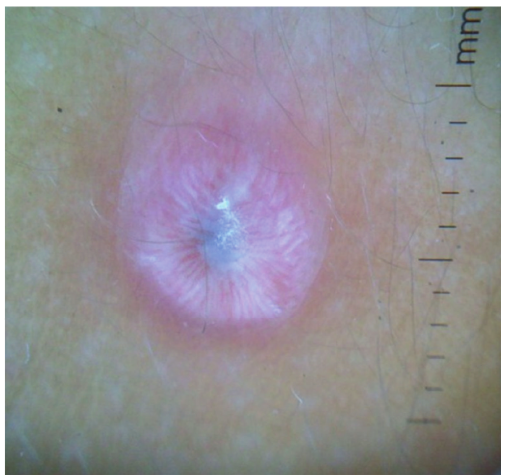
Figure 3: Central white-grayish area and white-pinkish streaks situated at the periphery, without dilated vessels.